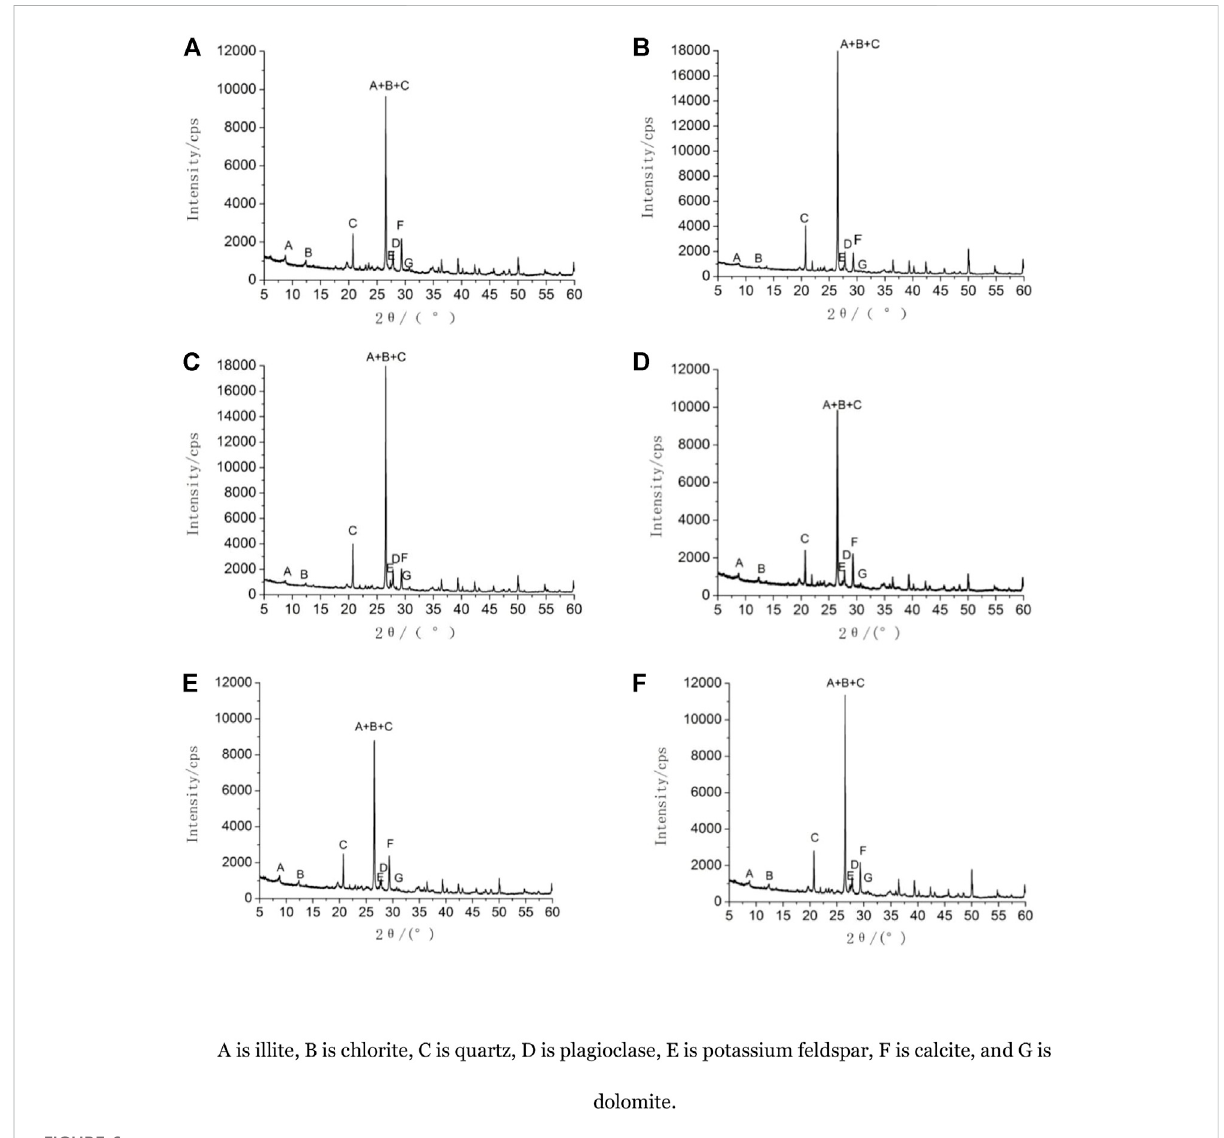
FIGURE 6 XRD diffraction patterns from samples in the disease segment (a 、 b 、 c) non-disease segment (d 、 e 、 f): (A) sample No. 1, (B) sample No.2, (C) sample No.3, (D) sample No. 4, (E) sample No.5, (F) sample No.6.